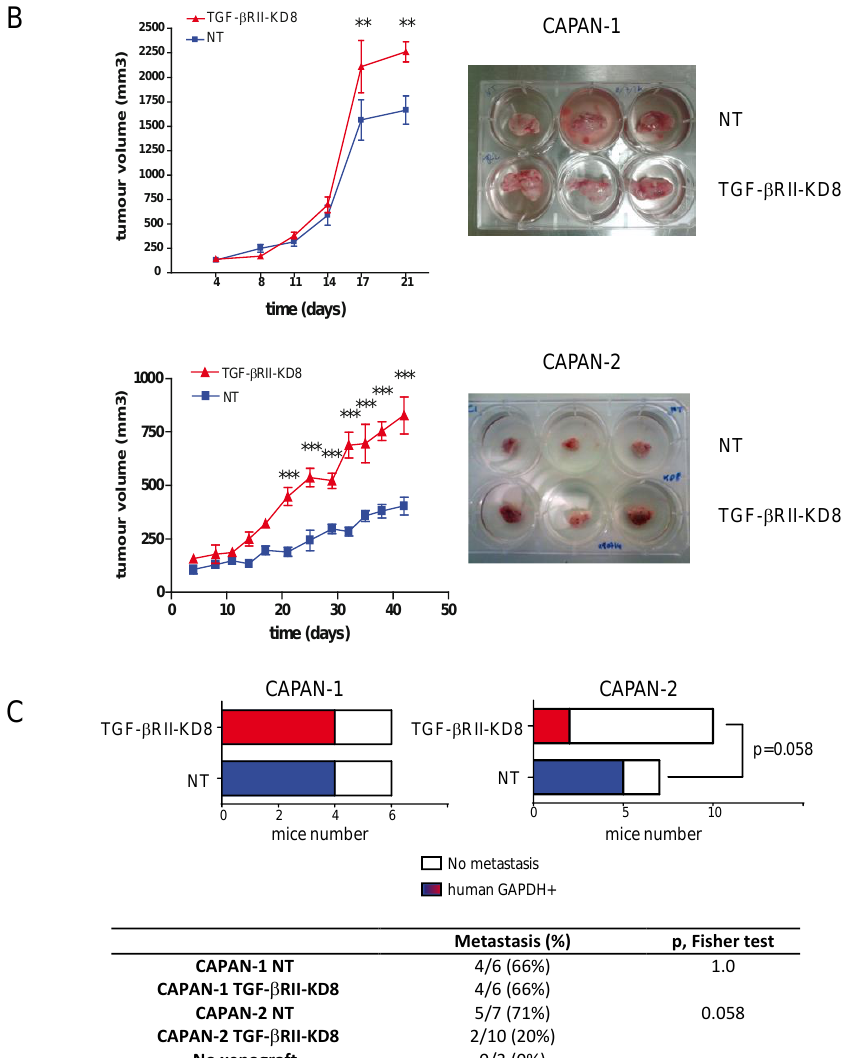
Figure 2. TGF- βRII alters tumor growth and migration in pancreatic cancer cells. ( A ) Wound healing closure of NT and TGF- βRII -KD CAPAN-1 and CAPAN- 2 cell lines using the IncuCyte™ chamber apparatus. N = 3. ( B ) Subcutaneous xenografts of NT/TGF- βRII -KD8 CAPAN-1 and CAPAN-2 cells in SCID mice. Tumour growth (mm3) was evaluated until sacrifice. ** p < 0.01 and *** p < 0.001 indicate